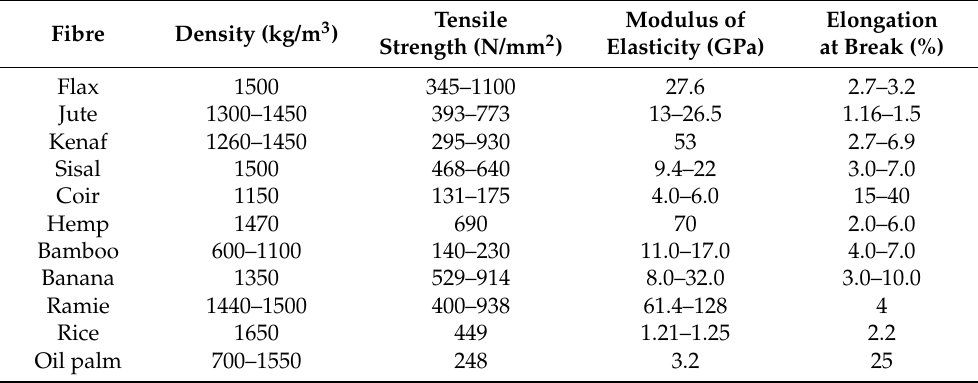
Table 2. Mechanical properties of some natural fibres [16,44].